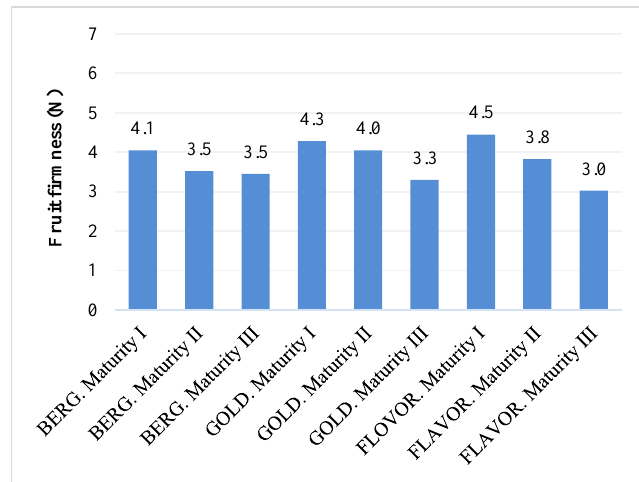
Figure 2. Effect of different harvest times (maturity classes) on the fruit firmness (N) percentage of Bergarouge, Gold Cot and Flavor Cot apricot.